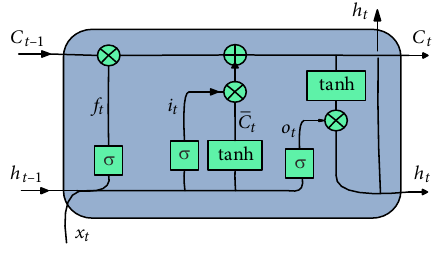
Figure 3. Unit structure of the